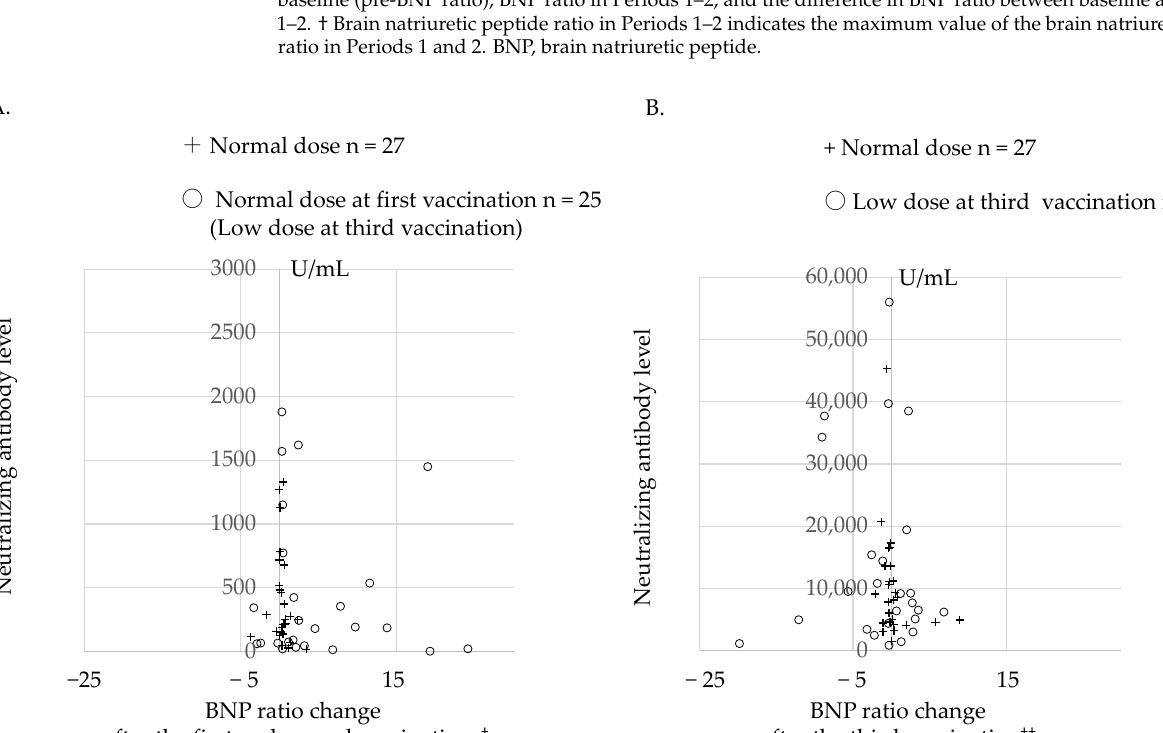
Figure 2. Relationships between neutralizing antibody levels and brain natriuretic peptide (BNP) ratio changes ( A ) after the first and second vaccinations and ( B ) after the third vaccination. +, 27 patients who received the normal dose of the first, second, and third vaccinations; the normal dose of the first and second vaccinations and low dose of the third vaccination; † , BNP ratio in Periods 1–2 minus the BNP ratio at baseline; †† , BNP ratio in Period 3 minus the BNP ratio in Periods